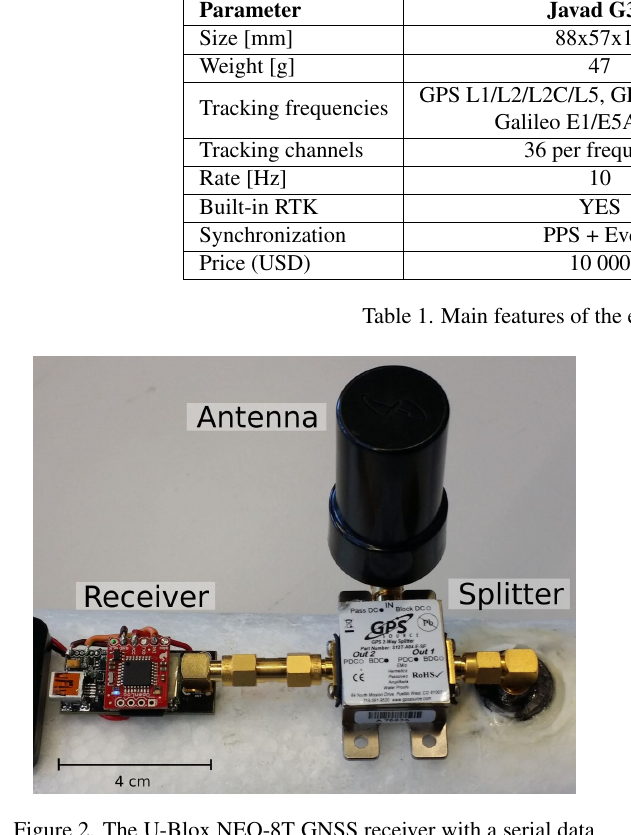
Figure 2. The U-Blox NEO-8T GNSS receiver with a serial data logger, GNSS signal splitter and L1/L2 GNSS antenna Maxtena. During the presented experiment, a second receiver Javad was connected via the splitter to provide a reference trajectory.